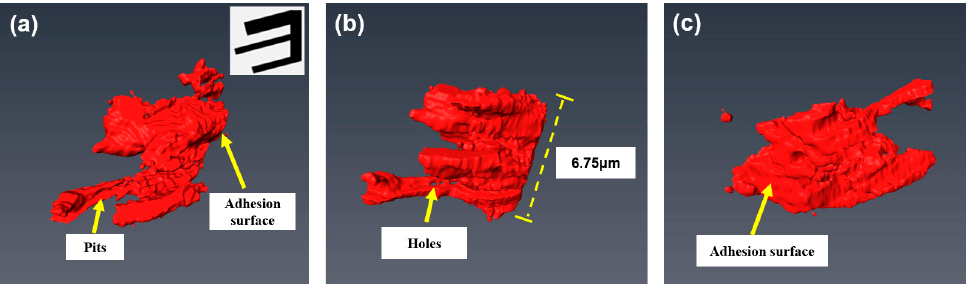
Figure 6. 3D morphology of primary Widmanstätten sideplates from different perspectives. ( a ) X– Y, ( b ) X–Z, ( c ) Y–Z.